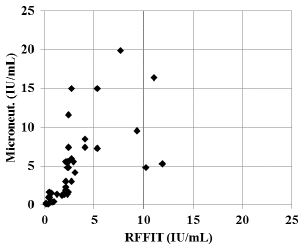
Figure 1. Comparison of rVNA titers (IU/mL) measured by the micro-neutralization test (microneut.) and RFFIT. Rabies virus neutralizing antibody was measure in individual serum samples by the micro-neutralization test (Microneut.) and RFFIT. Positive rVNA titers in IU/mL were plotted on a linear scale. The axis limits exclude four samples that had very high rVNA titers by both tests. The geometric mean titer was 3.4 IU/mL with the micro-neutralization test compared to 2.0 IU/mL with the RFFIT.